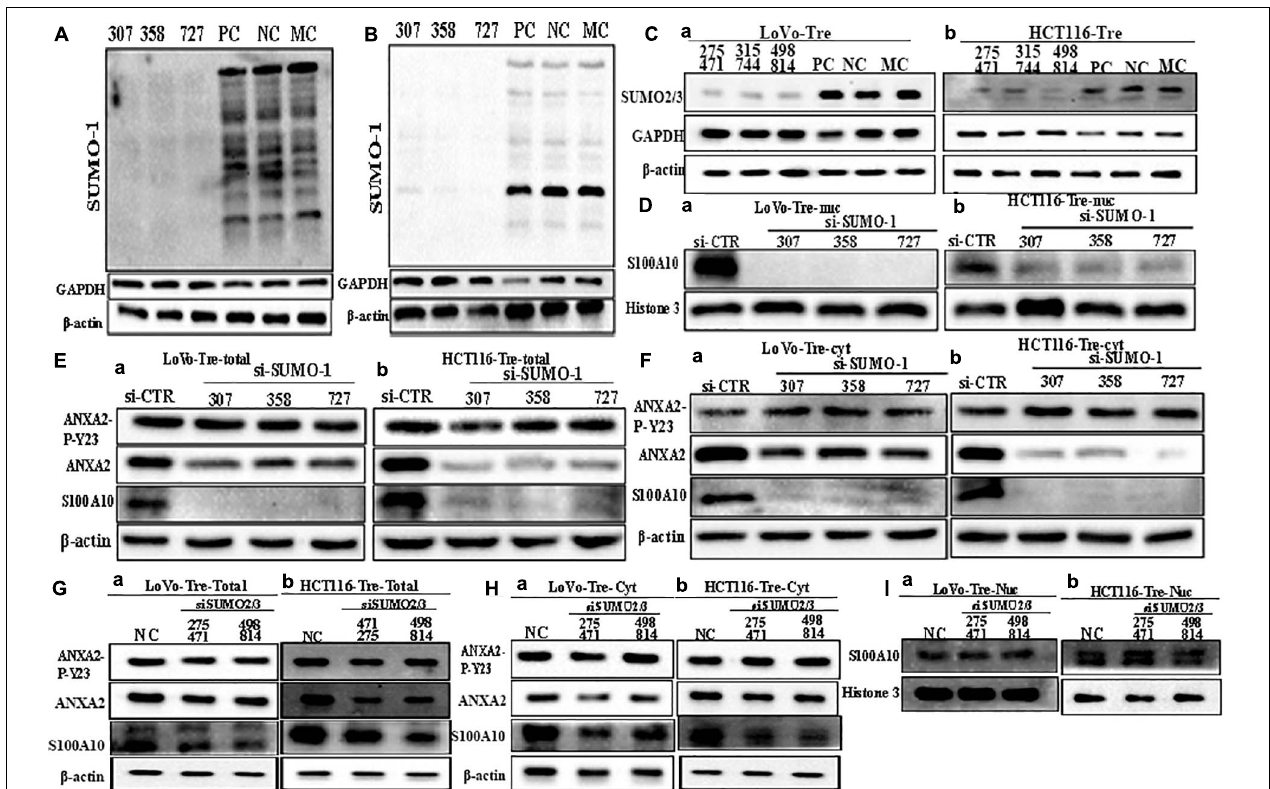
FIGURE 4 | S100A10 and related protein expression in PGCCs with their daughter cells after siRNA SUMO1, siRNA SUMO2/3, siRNA control, and negative control transfection. (A) Total SUMO1 expression in LoVo PGCCs with their daughter cells after three sequences of siRNA-SUMO1(307, 358, 727) transfection. (B) Total SUMO1 expression in HCT116 PGCCs with daughter cells after three sequences of siRNA-SUMO1(307, 358, 727) transfection. (C) (a) Total SUMO2/3 expression in LoVo PGCCs with their daughter cells after three sequences of siRNA-SUMO2/3(275471, 315744, 498814) transfection. (b) Total SUMO2/3 expression in HCT116 PGCCs with daughter cells after three sequences of siRNA-SUMO2/3(275471, 315744, 498814) transfection. (D). (a) Nuclear S100A10 expression in LoVo PGCCs with their daughter cells after siRNA-SUMO1 transfection. (b) Nuclear S100A10 expression in HCT116 PGCCs with their daughter cells after siRNA-SUMO1 transfection. (E) (a) Total ANXA-P-Y23, ANXA2, and S100A10 expression in LoVo PGCCs with their daughter cells after siRNA-SUMO1 transfection. (b) Total ANXA-P-Y23, ANXA2, and S100A10 expression in HCT116 PGCCs with their daughter cells after siRNA-SUMO1 transfection. (F) (a) Cytoplasmic ANXA2-P-Y23, ANXA2, and S100A10 expression in LoVo PGCCs with their daughter cells after siRNA-SUMO1 transfection. (b) Cytoplasmic ANXA2-P-Y23, ANXA2, and S100A10 expression in HCT116 PGCCs with their daughter cells after siRNA-SUMO1 transfection. (G) (a) Total ANXA-P-Y23, ANXA2, and S100A10 expression in LoVo PGCCs with their daughter cells after siRNA-SUMO2/3 transfection. (b) Total ANXA-P-Y23, ANXA2, and S100A10 expression in HCT116 PGCCs with their daughter cells after siRNA-SUMO2/3 transfection. (H) (a) Cytoplasmic ANXA2-P-Y23, ANXA2, and S100A10 expression in LoVo PGCCs with their daughter cells after siRNA-SUMO2/3 transfection. (b) Cytoplasmic ANXA2-P-Y23, ANXA2, and S100A10 expression in HCT116 PGCCs with their daughter cells after siRNA-SUMO2/3 transfection. (I) (a) Nuclear S100A10 expression in LoVo PGCCs with their daughter cells after siRNA-SUMO2/3 transfection. (b) Nuclear S100A10 expression in HCT116 PGCCs with their daughter cells after siRNA-SUMO2/3 transfection. Ctr, control cells; Tre, cells treated with CoCl 2 ; Cyt, cytoplasm; Nuc, nucleus.